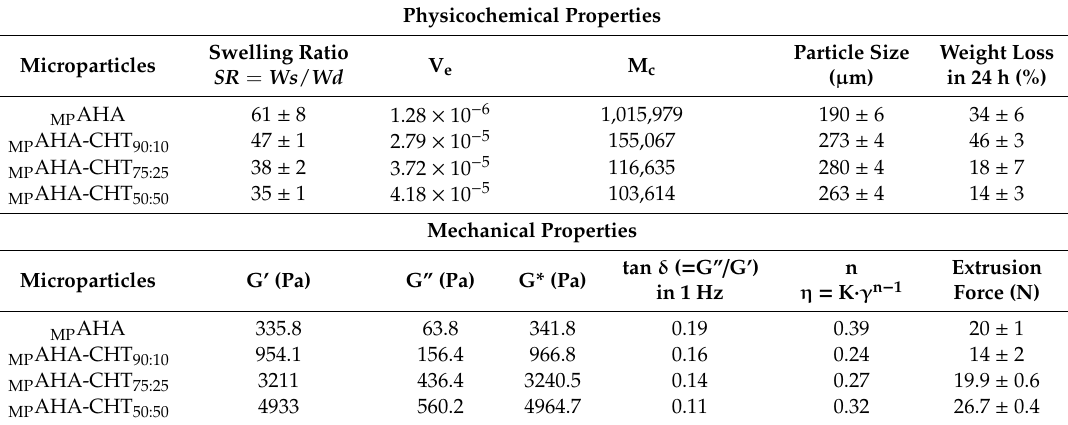
Table 1. Physicochemical and mechanical properties of the